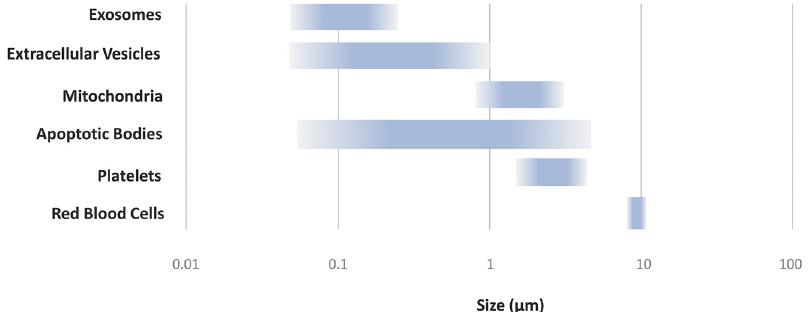
Figure 2: Overlapping size distributions of circulating